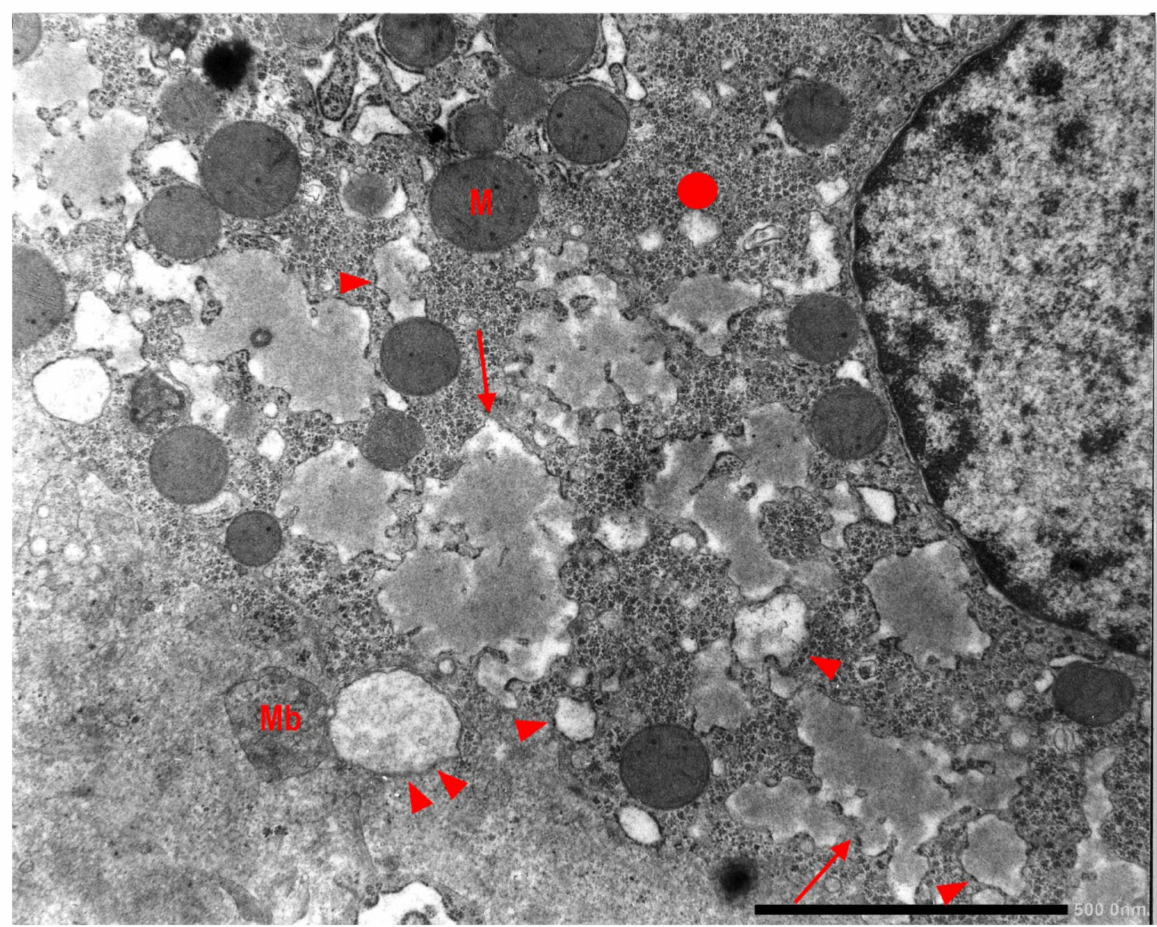
Figure 9. Pi MZ patient liver. The electronmicriphotpgraph shows AAT like material in dilated cisternae of the RER. The intraluminal material appears in the form of addensed granules. In a few cisternae the material is loose and made up of fragmented tangle filaments. This feature is more obvious in dilated cisternae nearly empty (single arrowheads and double arrow-head). The hepatocyte contains abundant glycogen (circle), mitochondria (M) and a multivesiculr body (Mb) (EM ×